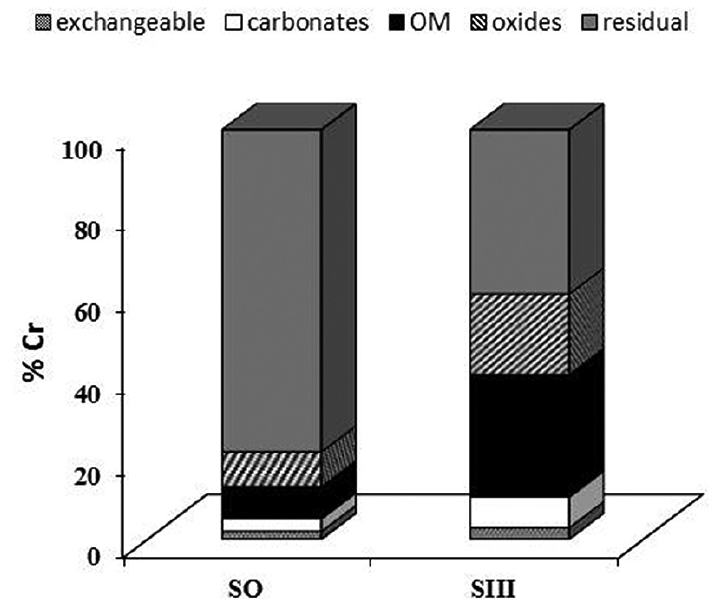
Figure 6. Percent distribution of chromium (%) in sequential extraction fractions for each